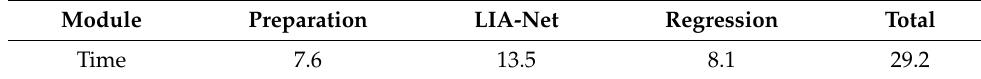
Table 5. Runtime of LIA-SC-Net in the validation dataset (Unit: ms).